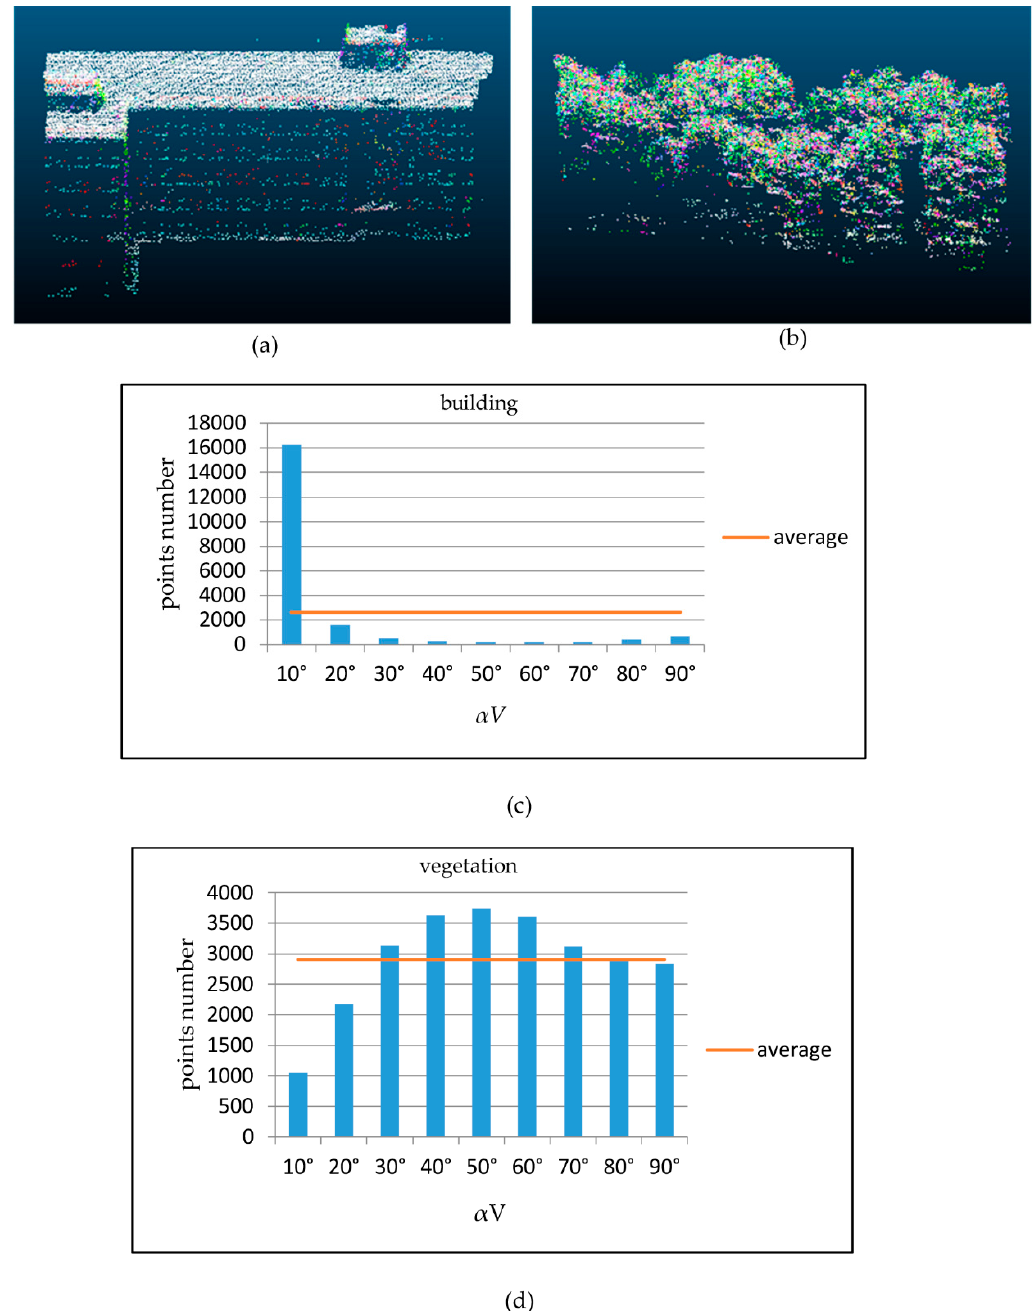
α α Figure 6. Example of the V histogram: ( a ) V of each point for one building cluster and Figure 6. Example of the α V histogram: ( a ) α V of each point for one building cluster and different α α ; ( b ) V of each point for one vegetation cluster; ( c ) the different color represent different V color represent different α V ; ( b ) α V of each point for one vegetation cluster; ( c ) the α V histogram of ( a ); V α histogram of ( a ); and ( d ) the V α histogram of ( b ). and ( d ) the α V histogram of ( b